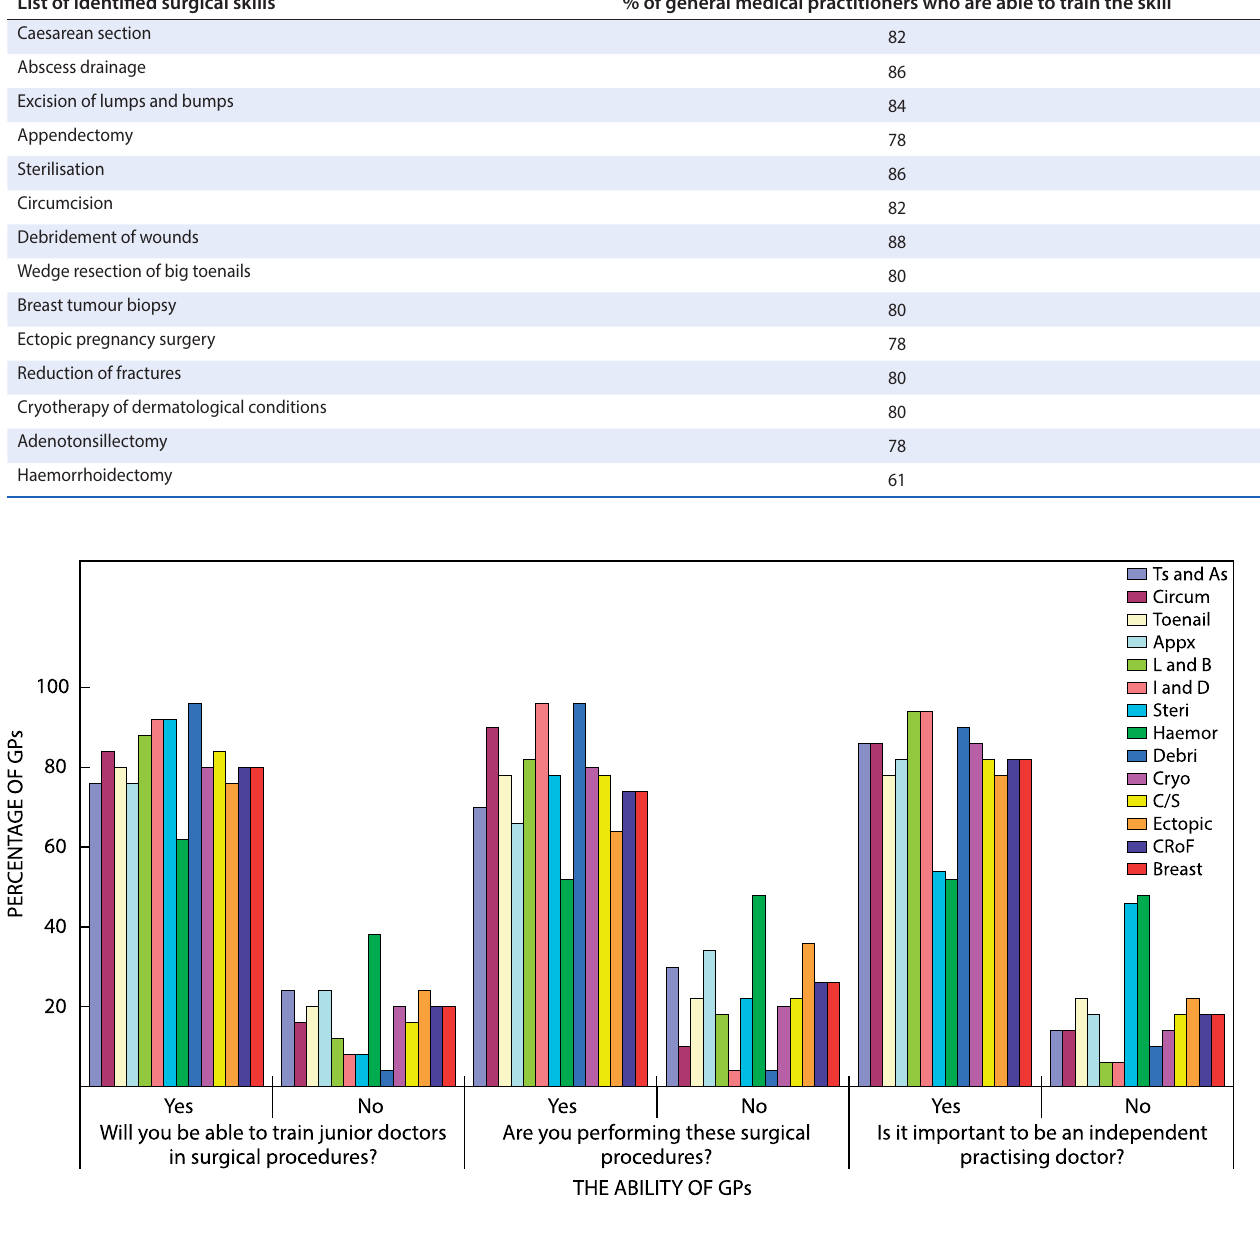
Appx: Appendix, Breast: breast tumour bioposy, Circum: circumcision, C/S: Caesarean section, CRoF: Closed reduction of fractures, Cyro: cyrotherapy of dermatological conditions, Debri: debridement of wounds, Ectopic: ectopic pregnancy surgery, GPs: general practitioners, Haemor: haemorrhoidectomy, I and D: incision and drainage, L and B: Excision Figure 1: The ability of GPs to train and evaluate juniors to practise independently. Are general medical practitioners performing surgical skills, do they think they can teach these skills, and are these skills important for independent practice?